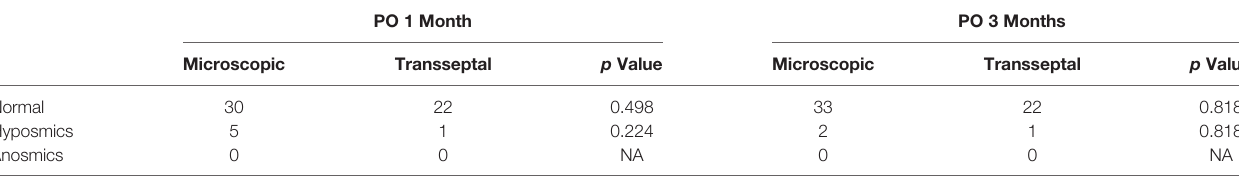
TABLE 6 | Olfactory function based on the Snif fi n ’ Sticks